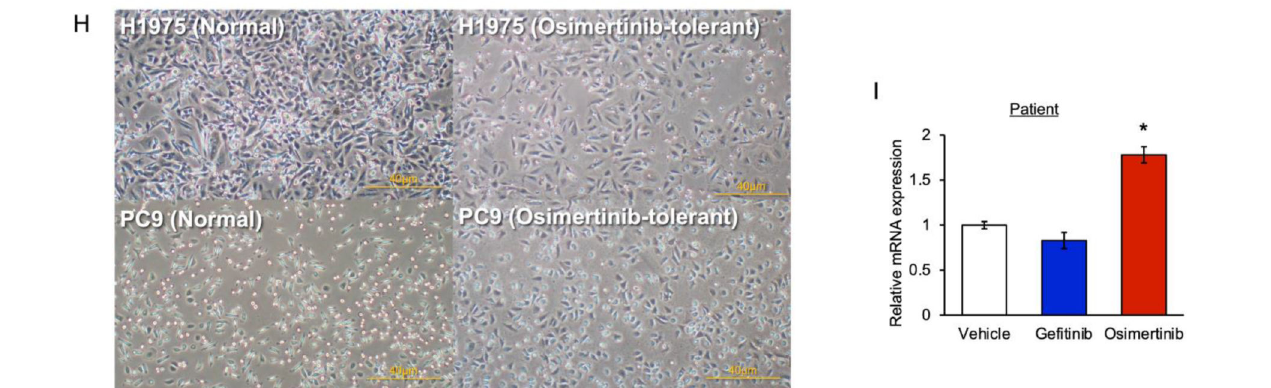
Figure 1. PAI-1 expression in EGFR-TKI-tolerant cancer cells. ( A , B ) qRT-PCR analysis of the expres- sion of PAI-1 mRNA in EGFR-TKI-tolerant PC-9 and H1975 cells compared with the corresponding mRNA expression in the vehicle controls. Relative expression level of PAI-1 is shown with standard error bars (n = 3); * p < 0.05 compared with cells exposed to vehicle controls (Student’s t -test or one-way ANOVA with Tukey’s test). ( C , D ) Concentration of PAI-1 protein in the culture medium of EGFR-TKI-tolerant PC-9 and H1975 cells compared with the PAI-1 protein concentration seen in the controls. Mean concentrations are shown with standard error bars (n = 5); * p < 0.05 compared with cells exposed to vehicle controls (Student’s t-test or one-way ANOVA with Tukey’s test). ( E ) Western blotting of PAI-1 in EGFR-TKI-tolerant PC-9 and H1975 cells compared with the vehicle controls. ( F , G ) Levels of PAI-1 protein normalized to GAPDH in EGFR-TKI-tolerant PC-9 and H1975 cells compared with the vehicle controls. The relative expression level of PAI-1 is shown with standard error bars (n = 3); * p < 0.05 compared with cells exposed to the vehicle controls (Student’s t-test or one-way ANOVA with Tukey’s test). ( H ) Micrographs of normal and osimertinib-tolerant cells. Upper-left: normal H1975, upper-right: osimertinib-tolerant H1975 cells; lower-left: normal PC-9 cells; lower-right: osimertinib-tolerant PC-9 cells; bar: 40 µ m. ( I ) qRT-PCR analysis of the expression of PAI-1 mRNA in EGFR-TKI-tolerant and control cancer cells derived from a patient with an EGFR exon 19 deletion and the T790M mutation seven months after afatinib administration. As in the other cell experiments, gefitinib and osimertinib were administered. The relative expression level of PAI-1 is shown with standard error bars (n = 3); * p < 0.05 compared with cells exposed to vehicle controls (one-way ANOVA with Tukey’s test). All the whole western blot figures can be found in